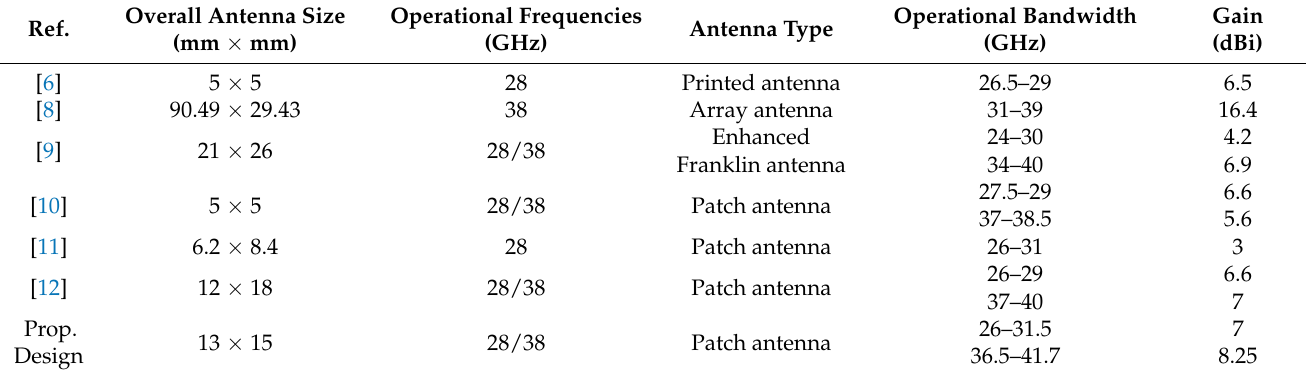
Table 1. Comparison of proposed dual-band antenna with the state of the art.